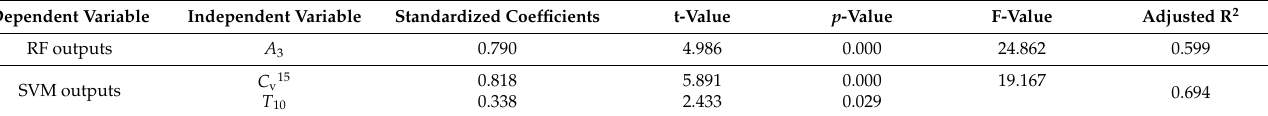
Table 13. Main model parameters of the stepwise regression analysis based on test set. Dependent